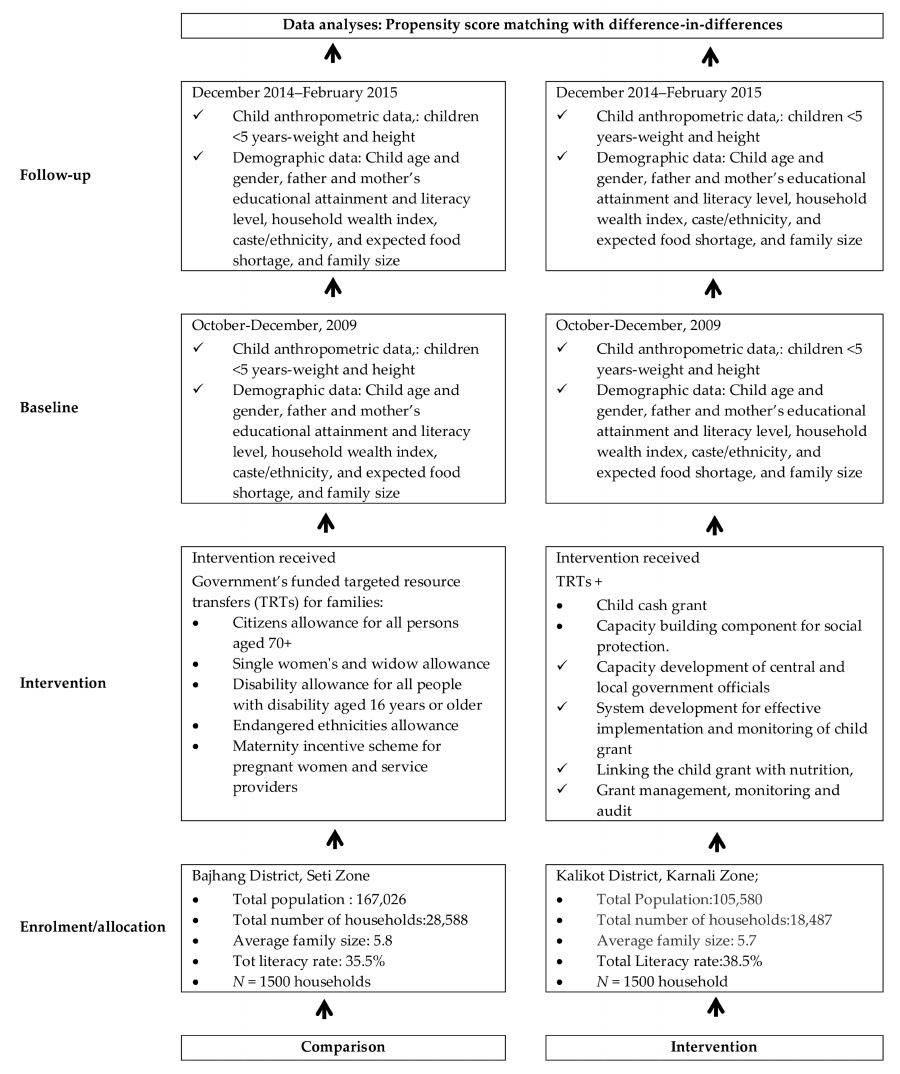
Figure 1. Flow diagram detailing the intervention implementation plan and data collection